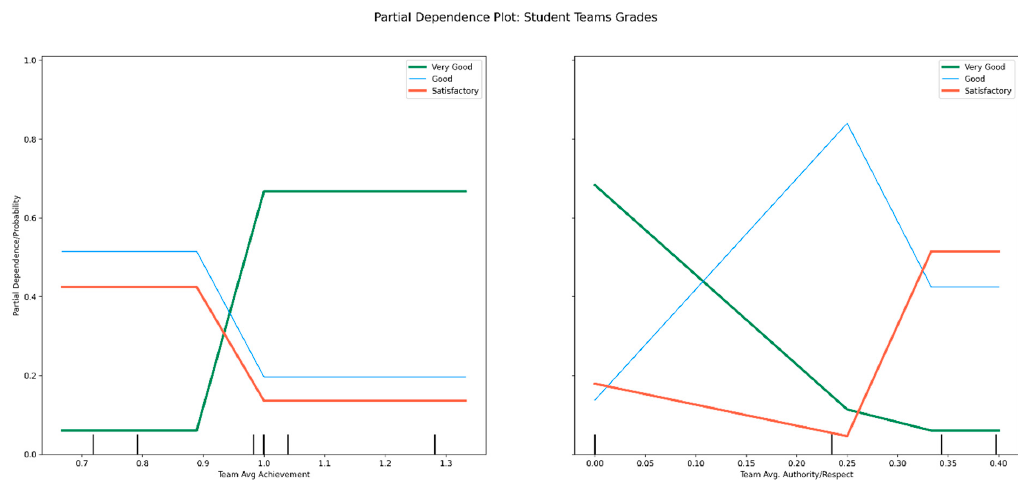
Figure A5. PDP of Student Teams Grades Model.